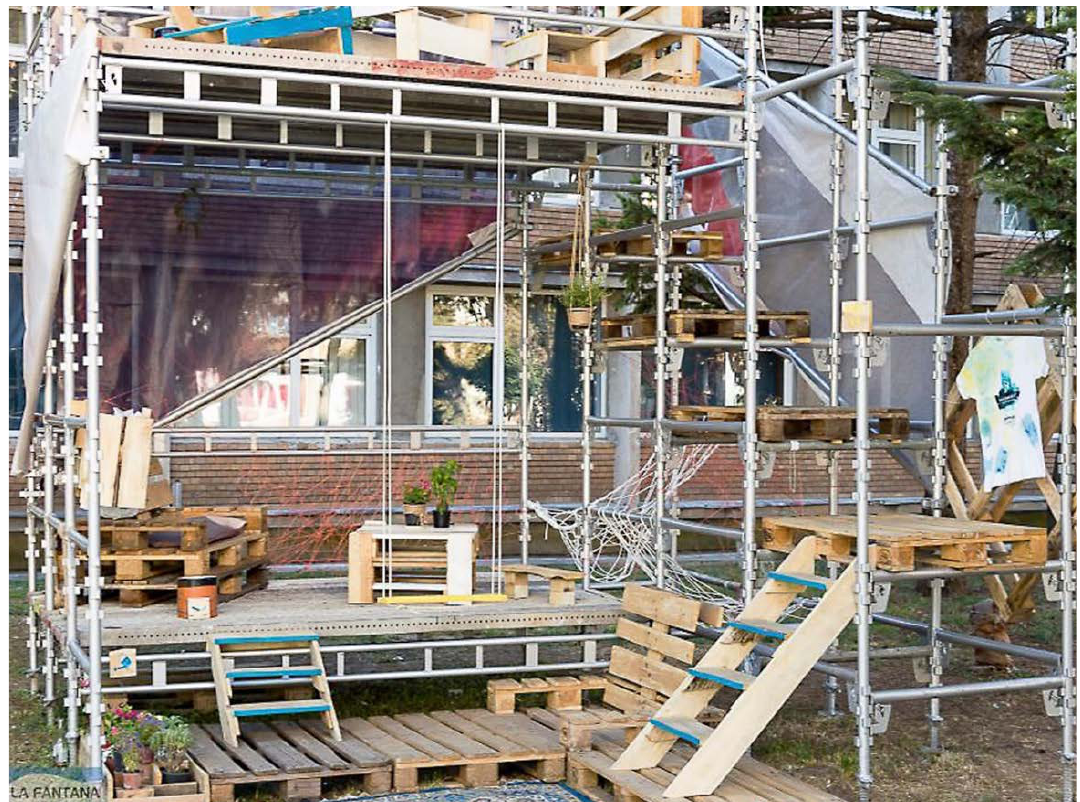
Figure 15: At the end of the